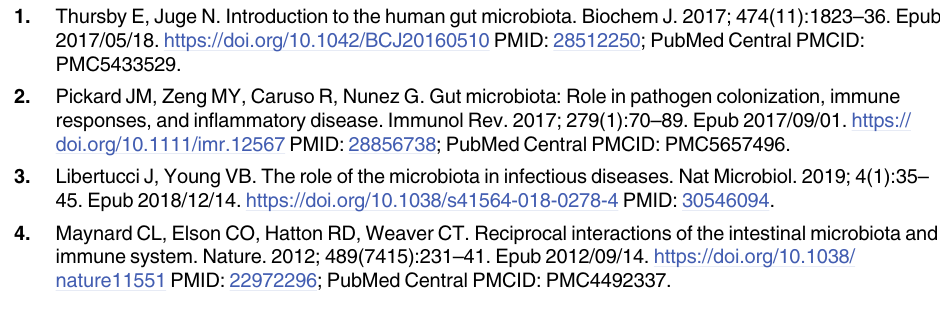
S8 Fig. GBC vs. WSD differences in C . rodentium are irrespective of IL-18 and IL-22. IL-18 KO ( A-C ), IL-22 KO ( D-F ) and Rag1 KO ( G-H ) mice were fed with GBC or WSD for 1 week before infected with C . rodentium . Fecal C . rodentium was measured at indicated days (A, D&G). Spleens were weighted (B&E) and colon was collected to process for HE staining (C&F) for IL-18 KO and IL-22 KO mice; colons collected from Rag1 KO mice were cut longi- tudinally to remove feces, washed in PBS completely before bioluminescent imaging (H). S1 Table. Diets composition used in this study. S1 Data. The numerical data used in all figures are